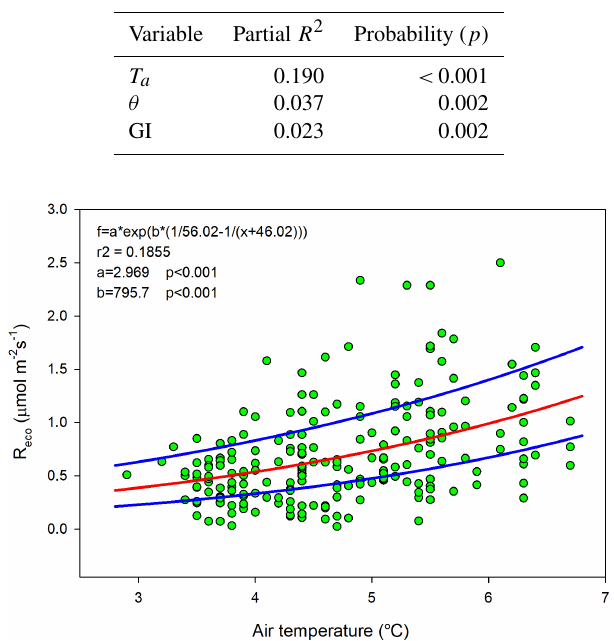
Figure 6. Measured ecosystem respiration ( R eco ; green dots) using chambers plotted against air temperature. The red curve is the fit- ted equation, and the blue curves are the corresponding boundaries when considering the standard deviation of the parameters.